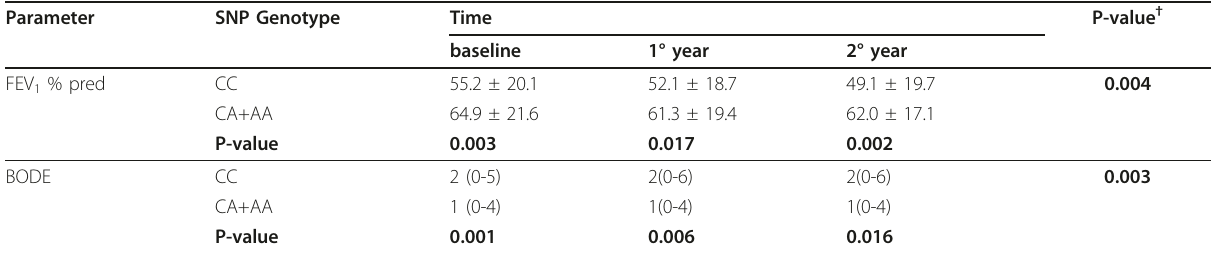
Table 4 Longitudinal association of TNFA -863 polymorphism with pulmonary function and BODE index in COPD